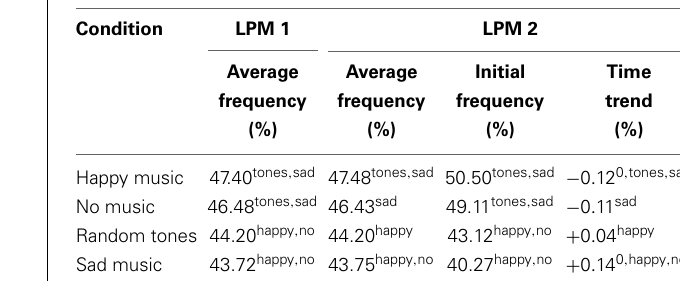
Table 1 | Random-effects linear probability models for the choice of the riskier lottery across the four